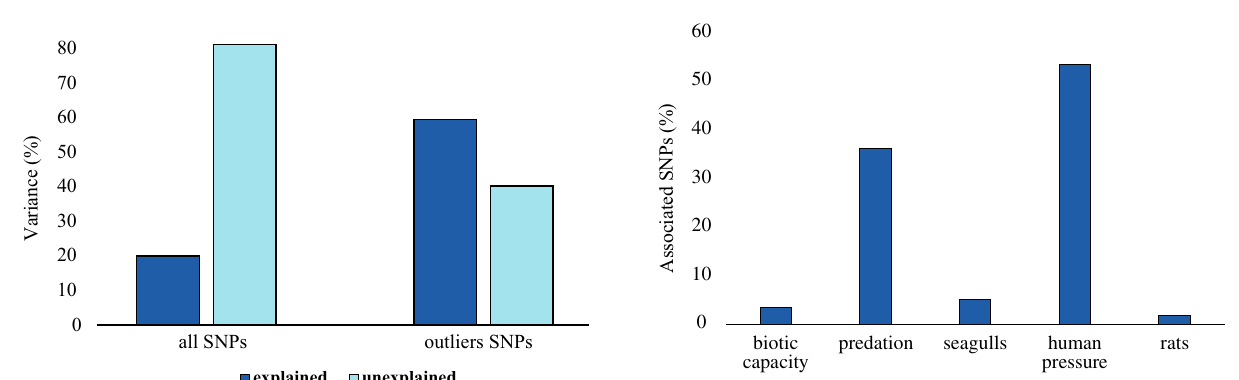
Figure 5. Variation explained by ecological variables computed in the RDA analysis based on all SNPs (72,846) and outlier SNPs only (1355) is indicated on the left graph. The percentage of associated SNPs for the retained variables after RDA analysis based on SNPs under selection is indicated on the right